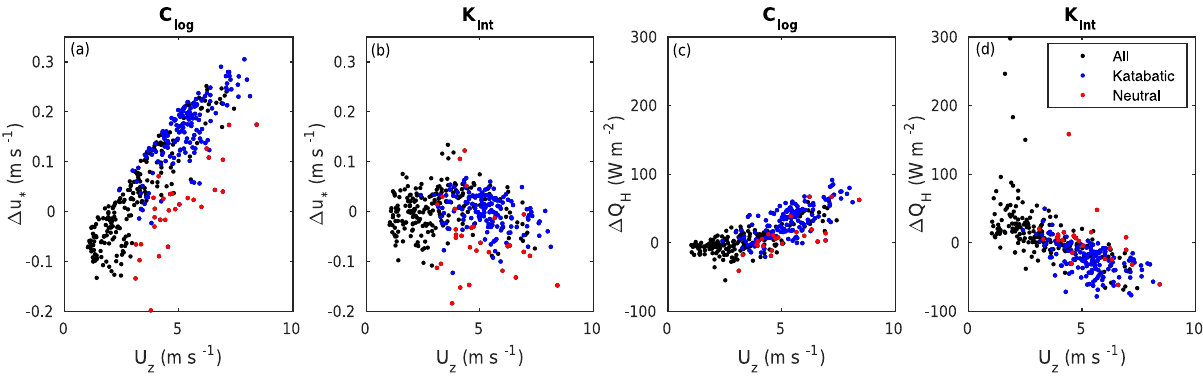
Figure 5. (a–b) Bias (modeled minus observed values) in u ∗ vs. the wind speed, and (c–d) bias in Q H vs. wind speed. Red points denote values during the near-neutral conditions